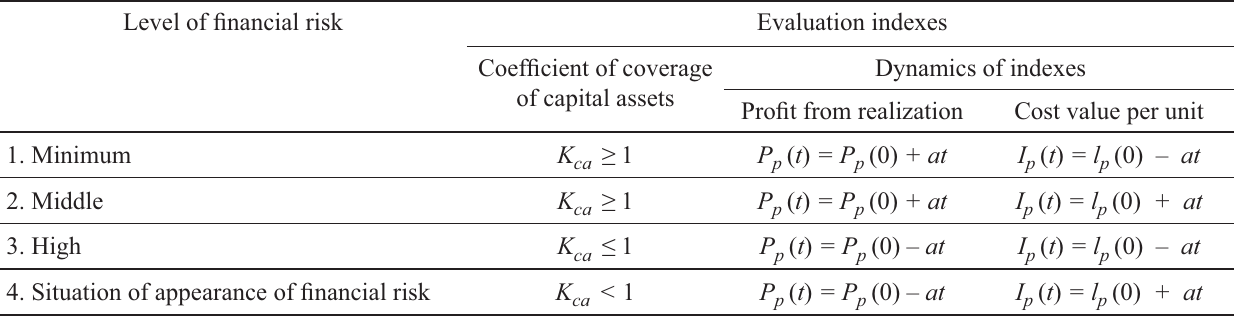
Table 5. Determination of level of fi nancial risk of enterprise, being at the growth stage Level of fi nancial